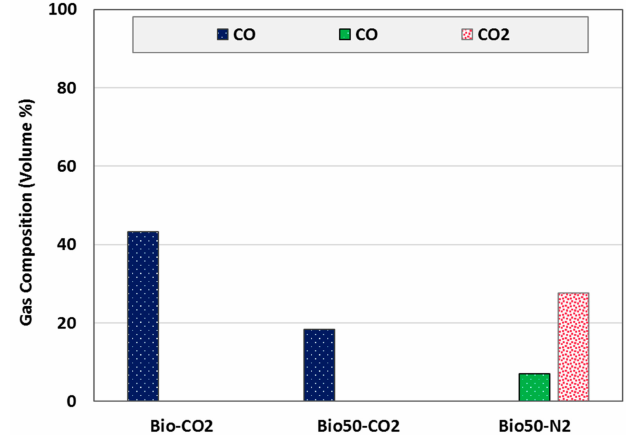
Figure 7. Volume % of emitted CO and CO 2 from di ff erent samples conversion under N 2 and CO 2 above ~600 ◦